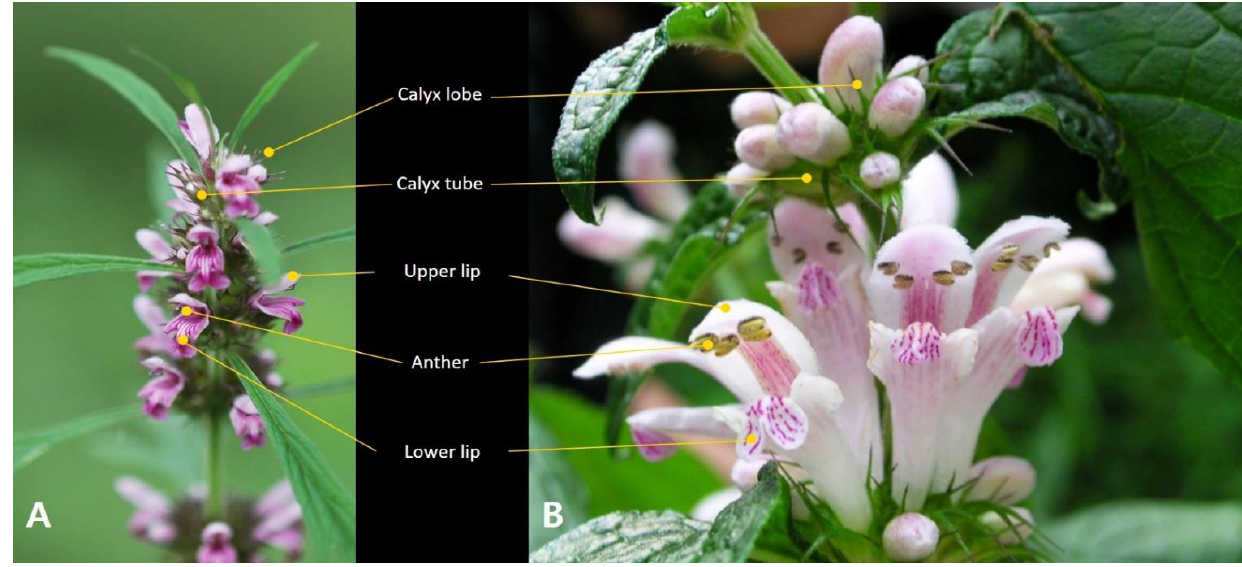
Figure 1. Inflorescences of the two Korean Leonurus species. ( A ) L. japonicus . ( B ) L. macranthus .